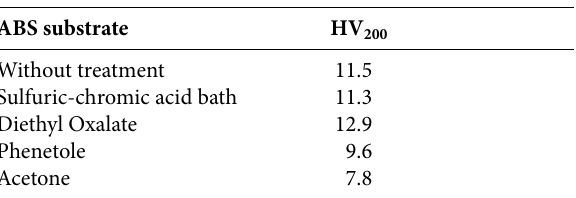
Table 3. Vickers hardness measurements on ABS surfaces with dif- ferent treatments. ABS substrate HV 200 Without treatment